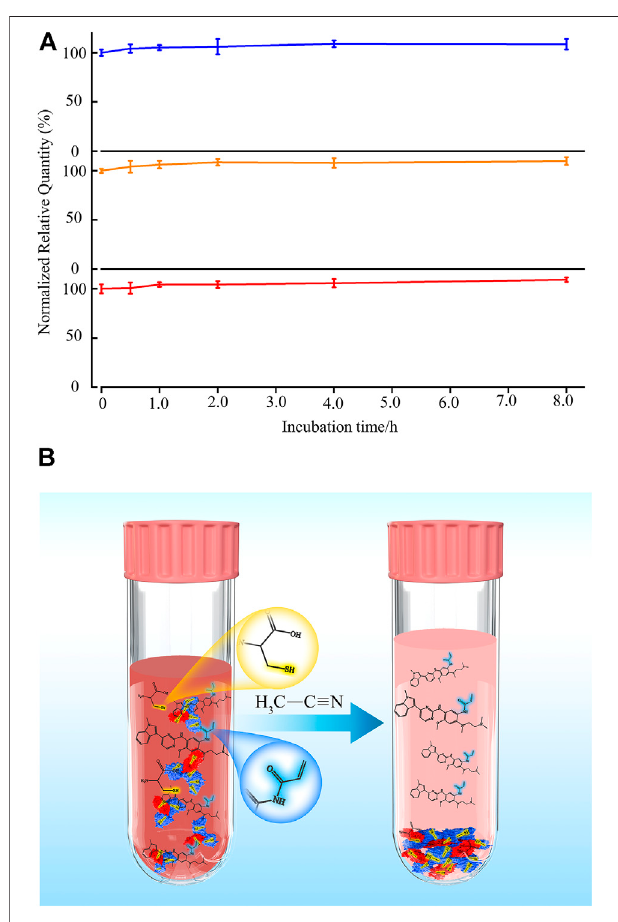
FIGURE 3 | (A) Addition of acetonitrile keeps the stability of osimertinib (blue), AZ-5104 (orange), and AZ-7550 (red) in rat plasma. Each 5.0 μ l chemical substrate (100 ng/ml) was incubated with 45 μ l rat plasma and vortexed for 1.0 min in the experiment. Then, 350 μ l acetonitrile was added, and 400 μ l solution was vortexed at 1,600 rpm for 5.0 min and incubated at 39 ° C for 0.5, 1.0, 2.0, 4.0, and 8.0 h before the mass spectrometry sample preparation and measurement. (B) Schematic representation of adding acetonitrile in plasma protects